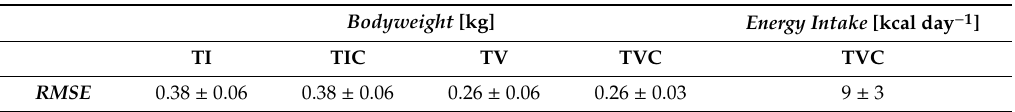
Table7. Rootmeansquareerror( RMSE )whencomparingtheMPCendvalueofbodyweightoutcomefor all MPCs tested and final energy intake suggestion for the MPC using the time-variant parameter DARX model with constraints (TVC) with the final bodyweight and energy intake values from the Minnesota starvation experiment. The MPC systems tested are the one using the time-invariant parameters model (TI), the same one but adding constraints (TIC), and the MPC system using the time-variant parameter DARX model (TV) and this one with constraints (TVC). The RMSE for bodyweight has kg as units and the RMSE for energy intake has kcal day − 1